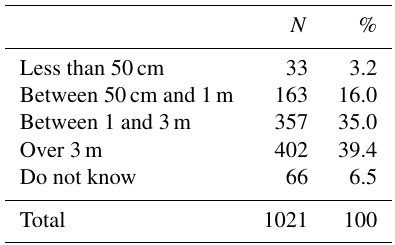
Table 4. How high should the water level rise be to be dangerous for people near the shore? N % Less than 50cm